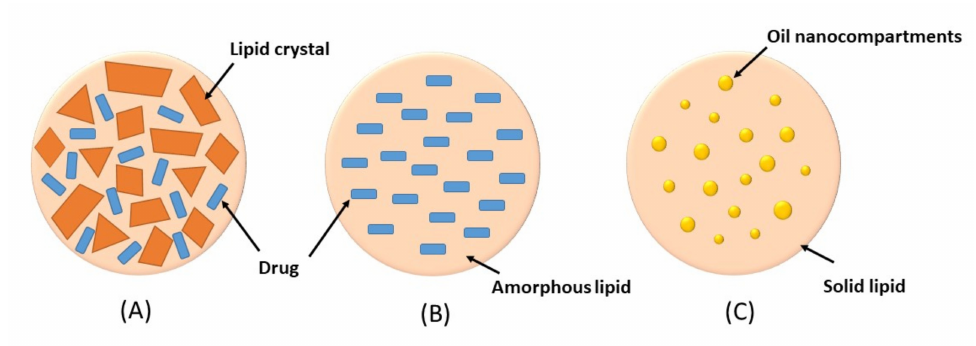
Figure 2. Types of NLCs ( A ) imperfect crystal type, ( B ) amorphous type, ( C ) multiple oil-in-fat-in- water